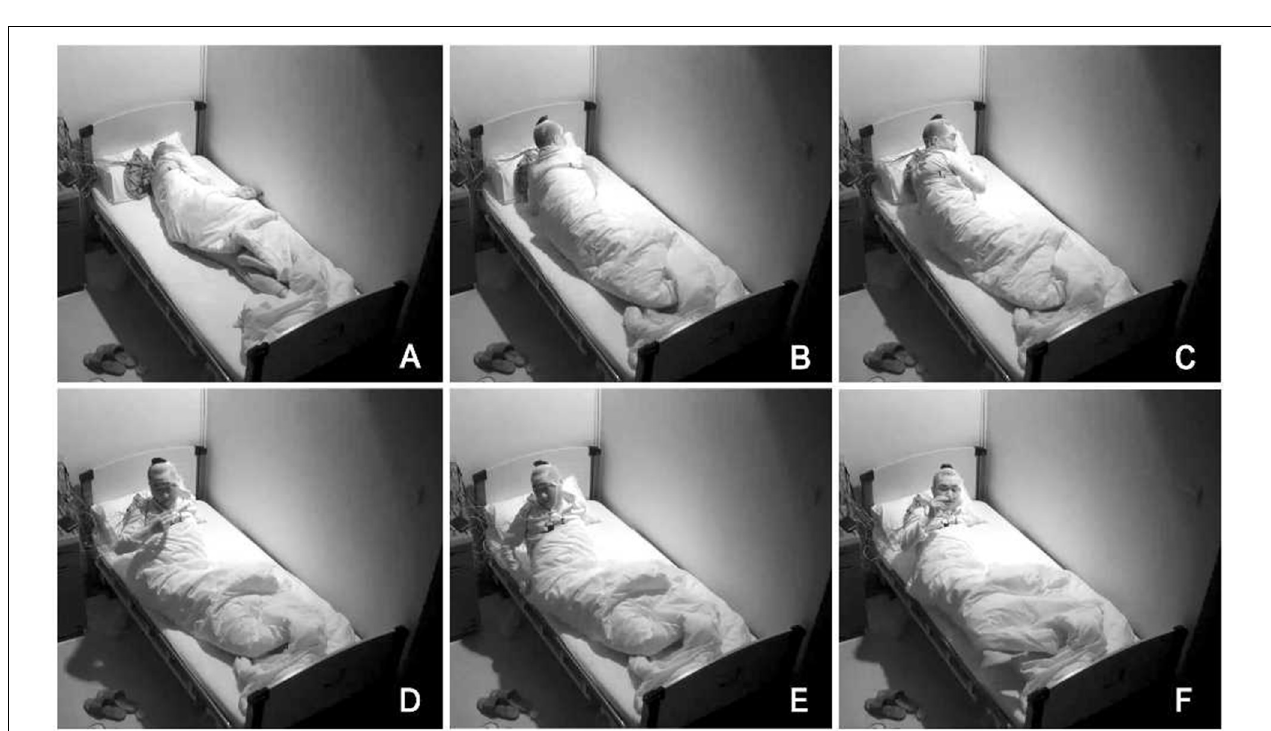
reversibility of sleep, without which it would be identical to coma. In this dynamic perspective, ongoing phasic events carry on the one hand arousal influences and on the other elements